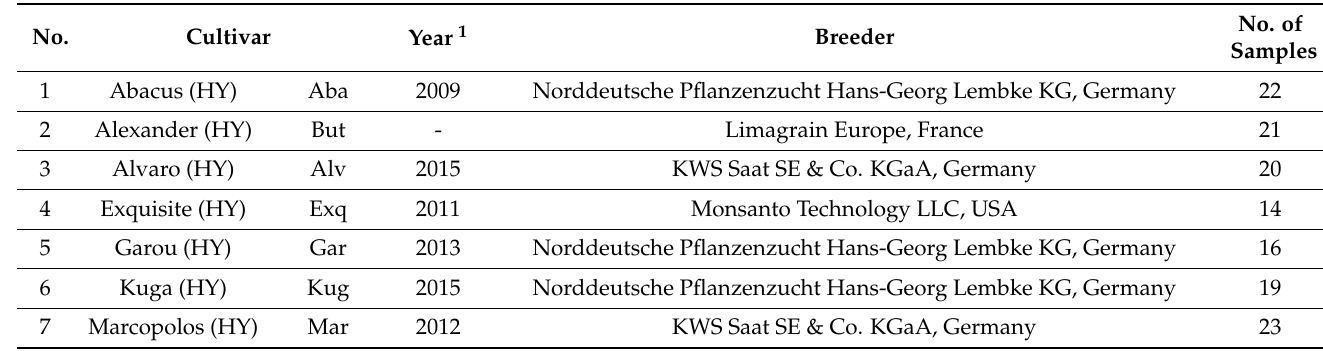
Table 3. Characteristics of oilseed rape cultivars and the number of samples